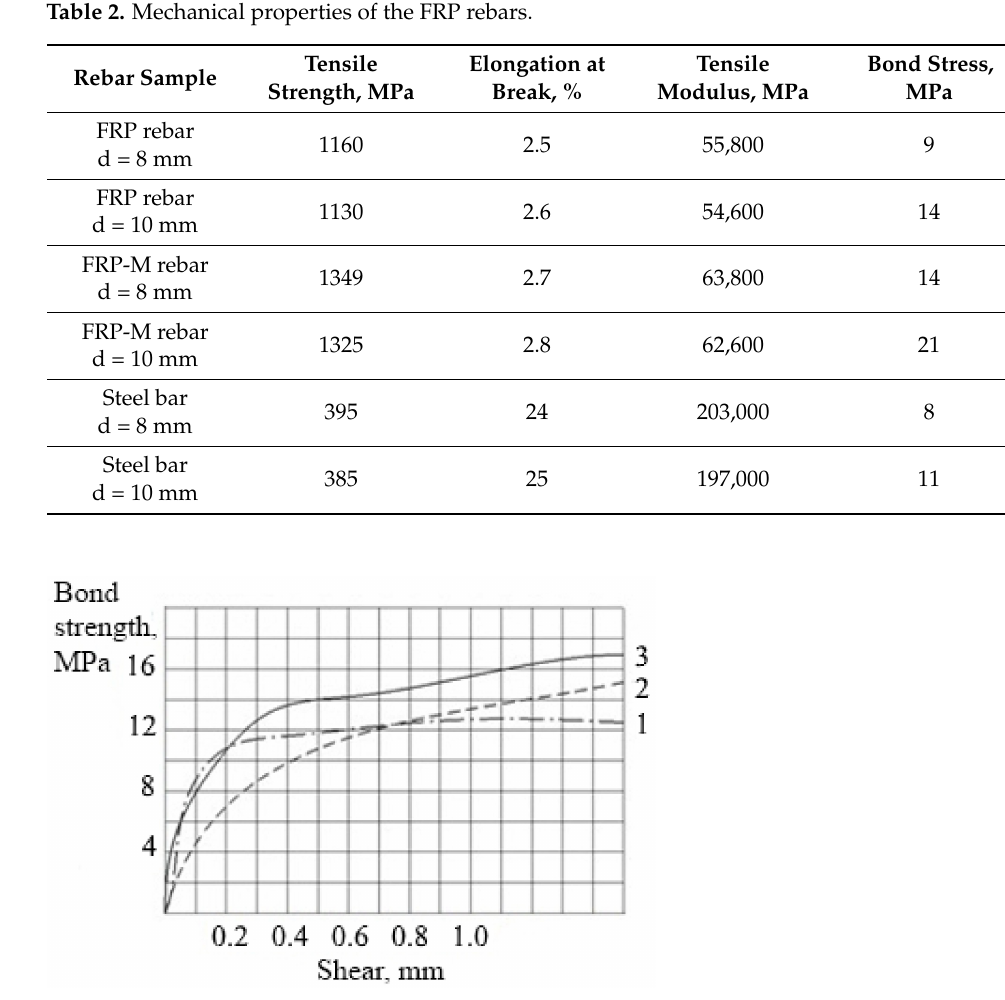
Figure 8. Diagram of adhesion of rebar to concrete of grade B35: 1—steel rebar; 2—fiberglass rebar; 3—basalt FRP rebar sprayed with a mix of basalt fiber and